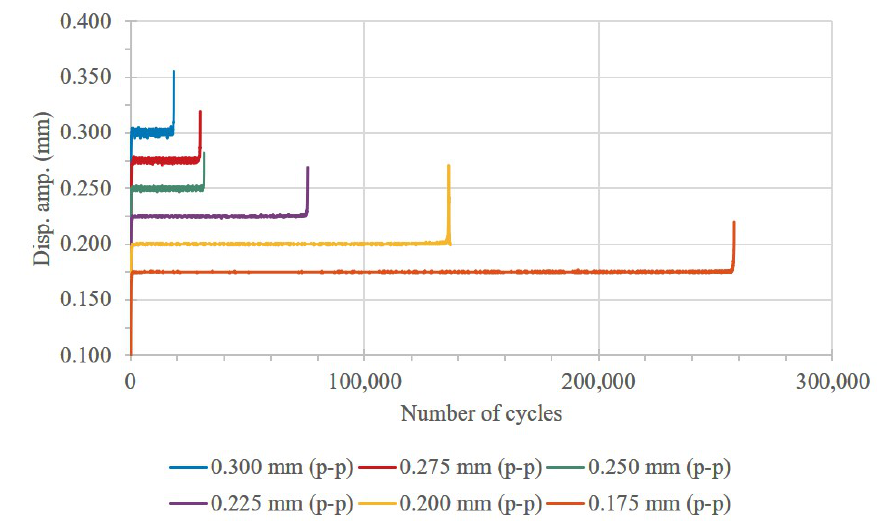
Figure 9. Displacement amplitude control of fine finished wrought specimens up to the entire fatigue life